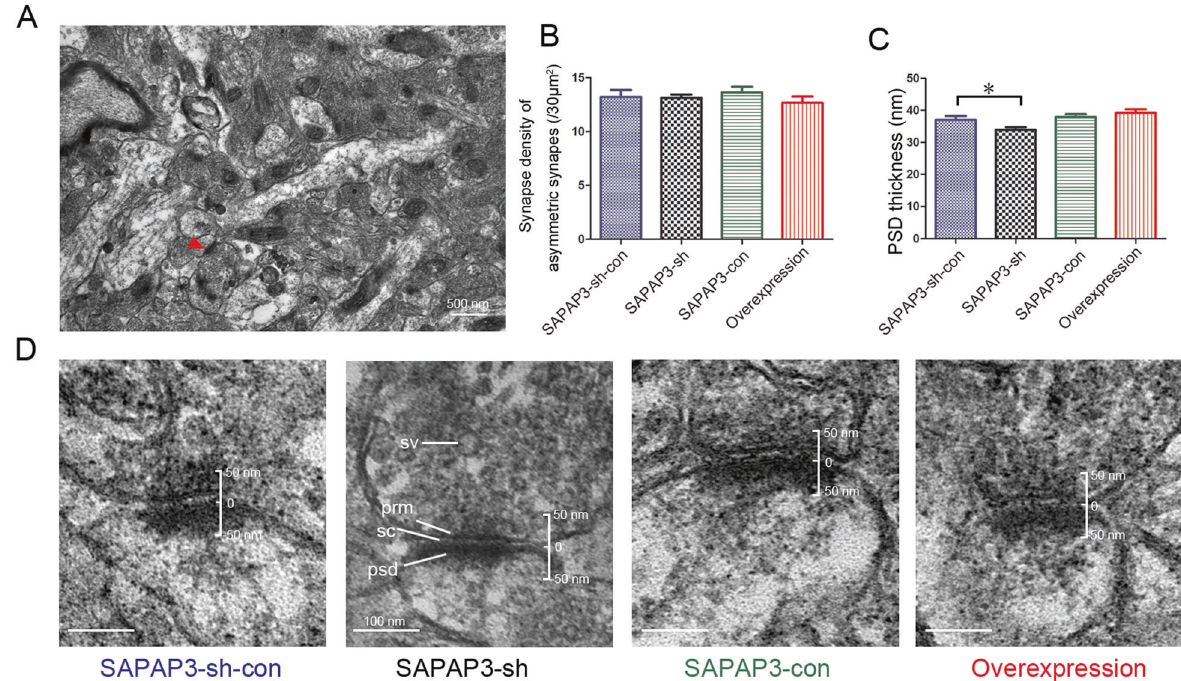
Fig. 7 Ultrastructural morphological changes in the PSD. A Representative electron micrographs show the distribution of asymmetric synapses at a magni fi cation of 25,000. The arrow shows an asymmetric synapse. B As shown in the bar graph, no signi fi cant difference in the density of asymmetric synapses was found among the groups (/30 μ m 2 ) ( n = 24 in each group). C The thickness of the PSDs in the SAPAP3-sh group ( n = 132) was signi fi cantly decreased compared with that of the PSDs in the SAPAP3-sh-con group ( n = 110). Representative images of the different groups are shown in D . Synaptic vesicle (sv), postsynaptic density (PSD), presynaptic membrane (prm), synaptic clearance (sc). Data are presented as means ± SEM, * p <